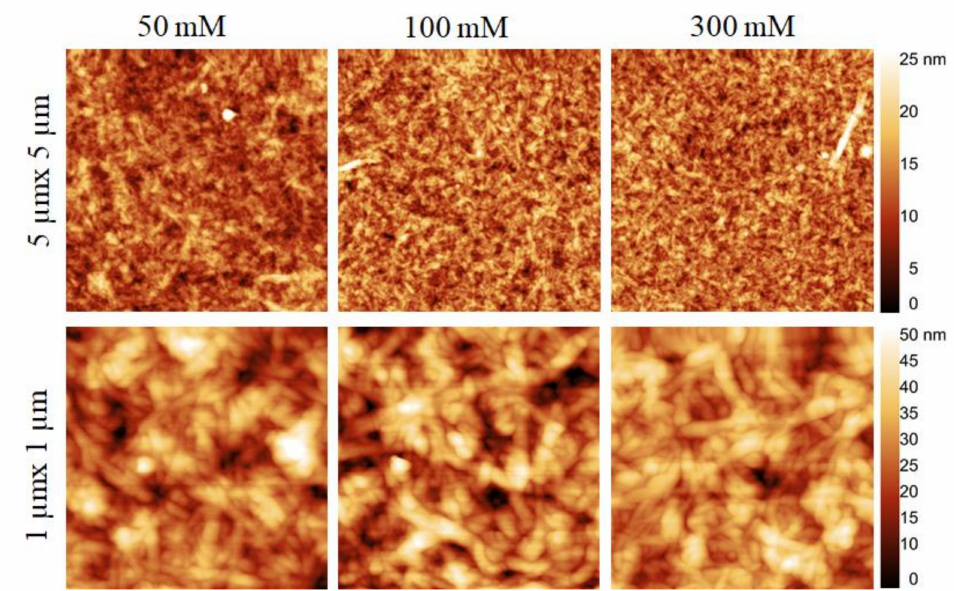
Figure 5. AFM height images ( top : 5 µ m × 5 µ m, bottom : 1 µ m × 1 µ m) of of CNCs coating in bilayer 3 created on SiO 2 surface as a function of ionic strength of PEI solution.